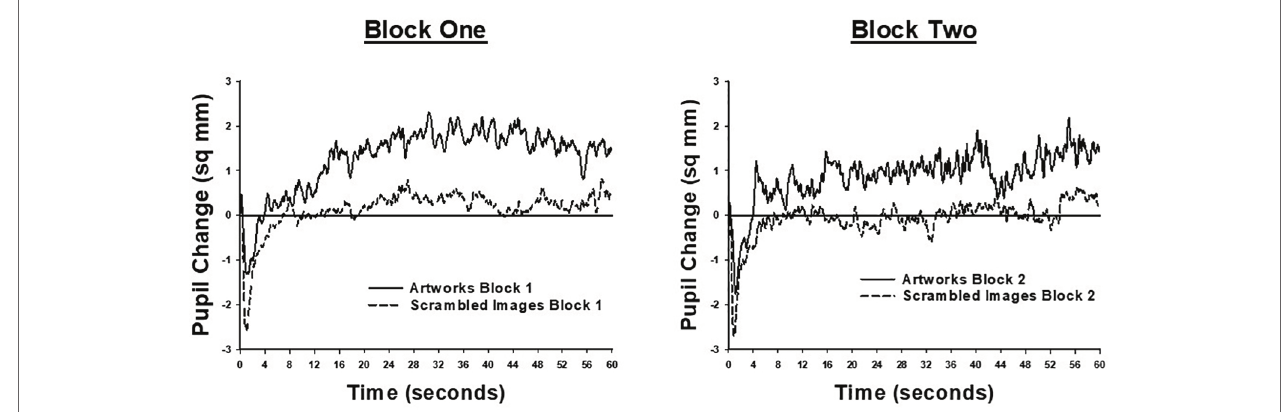
FIGURE 3 | Moment to moment changes in pupil size, when participants viewed landscape artworks (solid lines) and scrambled images (dashed lines). Each plot shows the difference between pupil size at each time-point during the 60-s image viewing period and average pupil size when viewing the uniform gray screen presented before each image. The left-hand panel shows data from the first trial block, comprising 17 images; the right-hand panel shows data from the second trial block, comprising nine